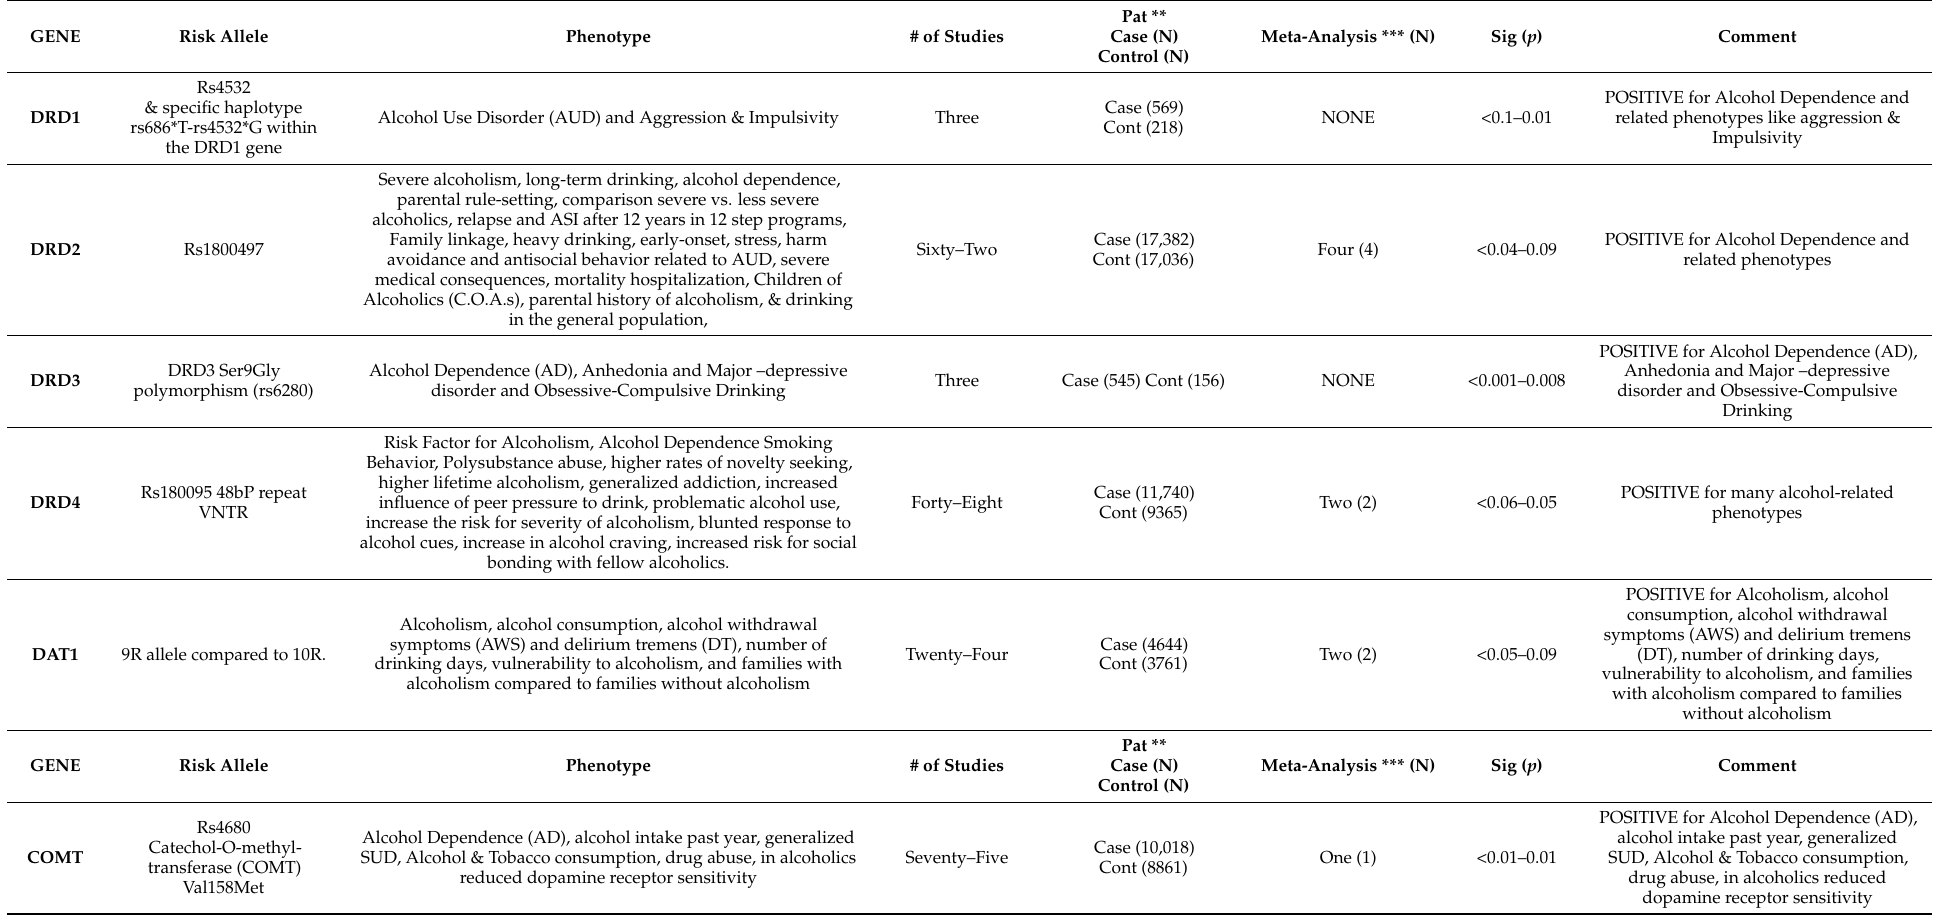
Table 1. Summary of Studies used for Cases vs. Controls for Alcohol Use Disorder (AUD)